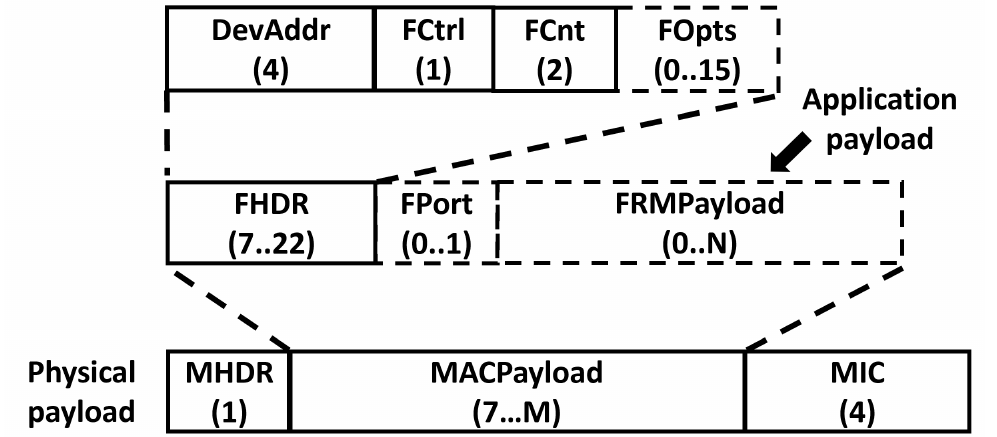
Figure 3. LoRaWAN message